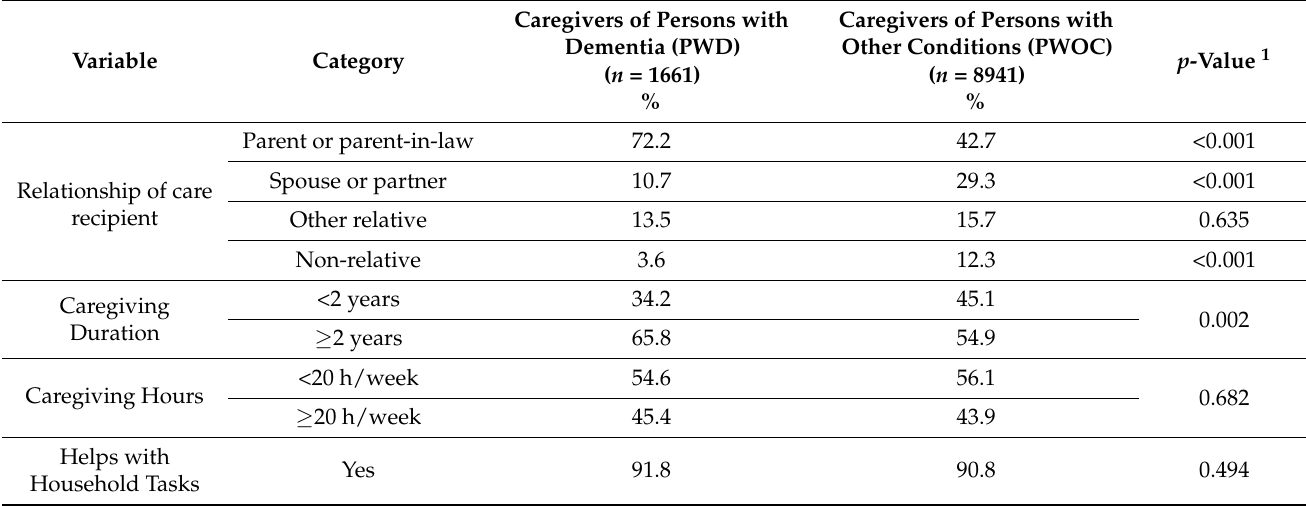
Table 2. Characteristics of Baby Boomer Caregivers of Persons with Dementia (PWD) and Caregivers of Persons with Other Conditions (PWOC), Behavioral Risk Factor Surveillance System,